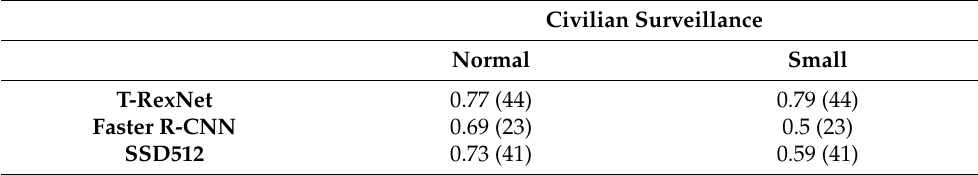
Table 4. Comparison of F1 scores achieved in the Civilian surveillance scenario. Numbers in brackets represent the measured speed, in frames per second, with the Desktop platform. This scenario is splitted into the sub-cases of normal and small object size to highlight the results of our method when objects are particularly small.